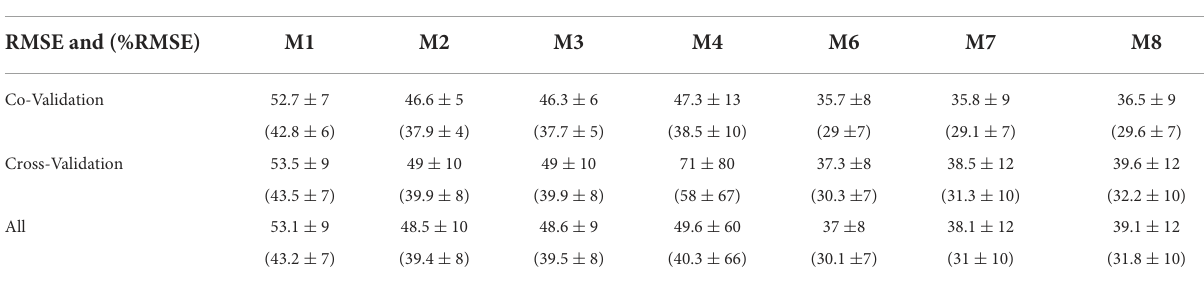
TABLE 3 Overall model performance for models M1 to M4 (backscatter based) and M 6 to M 8 (backscatter and height based). Backscatter based Backscatter and height based RMSE and (%RMSE)